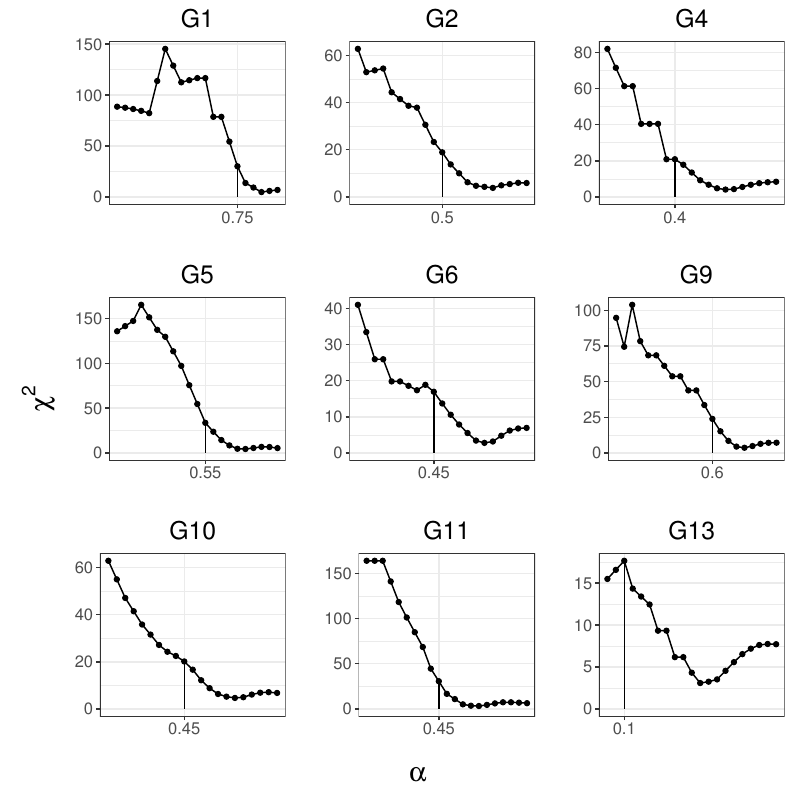
Figure 4. Plots of the chi-square test statistics as α changes from 0 to 1, and the selected optimal correction rate α ∗ for some grid